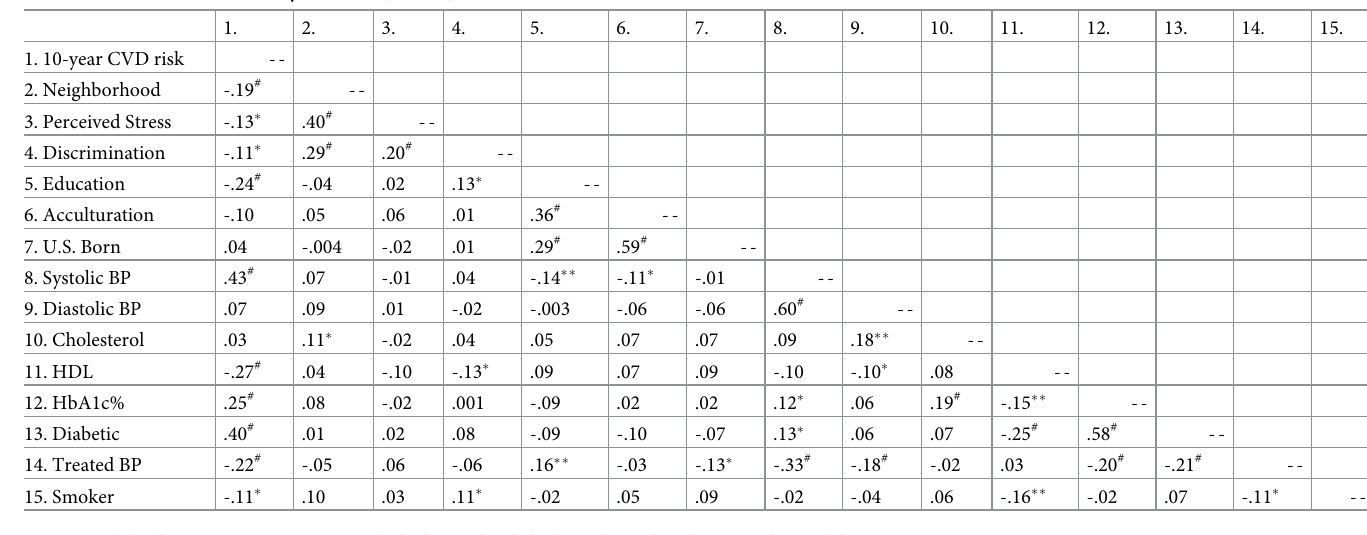
Table 2. Correlations of all study variables ( n =